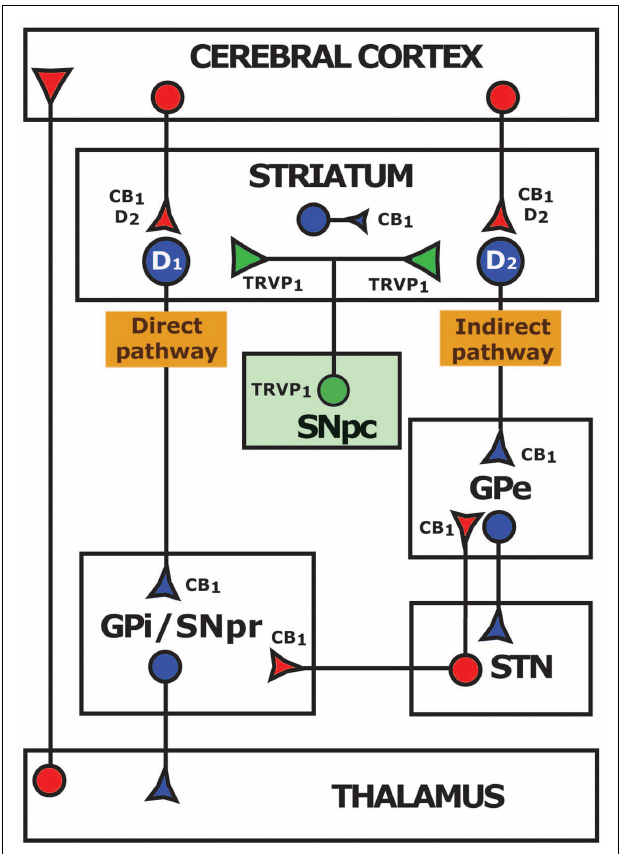
FIGURE 1 | Distribution of CB 1 andTRPV 1 receptors and their coexpression with dopaminergic D 1 and D 2 receptors in a simplified diagram of the basal ganglia circuits. GABAergic inhibitory pathways are represented in blue and glutamatergic excitatory pathways in red. Modulatory dopaminergic connections are indicated in green. CB 1 , cannabinoid receptor type 1;TRPV 1 , transient receptor potential vanilloid type 1; D 1 , dopaminergic receptor type 1; D 2 , dopaminergic receptor type 2; GPe, external globus pallidus ; GPi, internal globus pallidus ; STN, subthalamic nucleus ; SNpc, substantia nigra pars compacta ; SNpr, substantia nigra pars reticulata